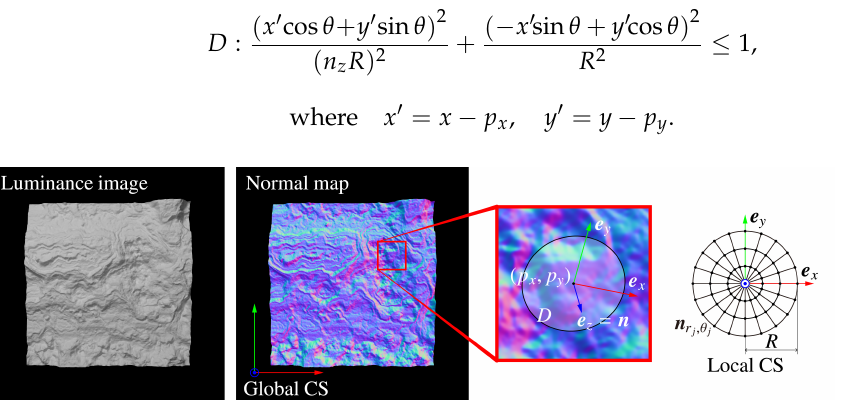
Figure 1. Local coordinate system (CS)